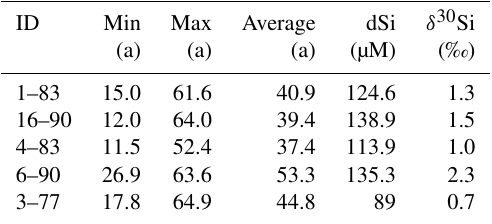
Table A2. Groundwater residence times from Bryan et al. (2020) and corresponding Si isotope